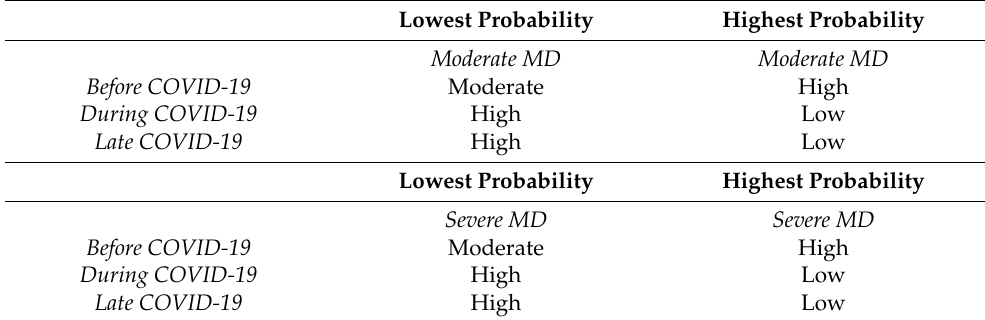
Table 7. Predictive probabilities of moderate and severe mental distress levels by physical exercise frequency and COVID-19 era during